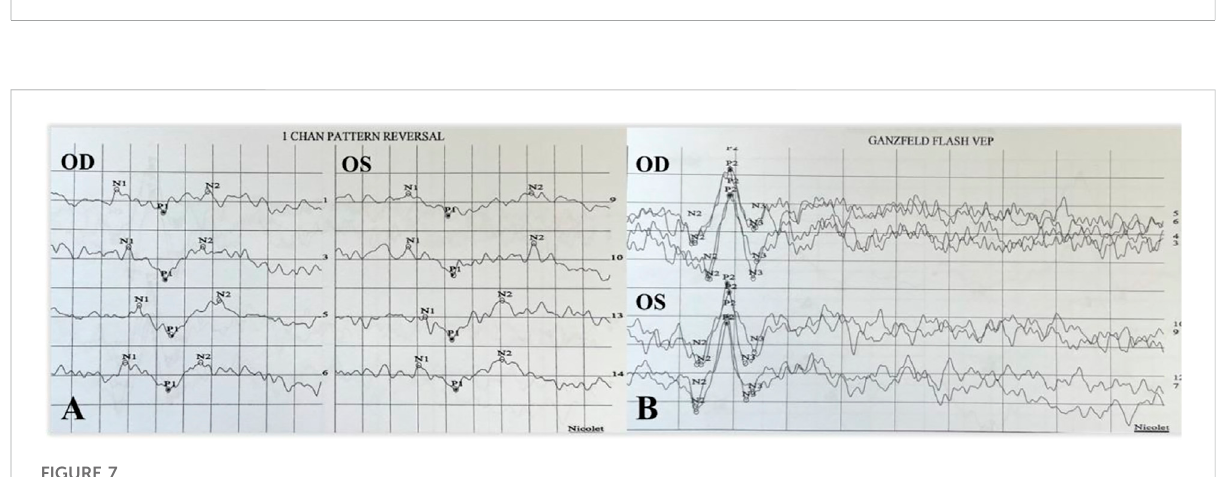
FIGURE 6 Examinationresultsoftheproband ’ smother. (A,B) Arcspotofmyopiaintemporalopticdiscs. (C,D) OCTshowedthattheinnerandouterlayers of central fovea were normal in both eyes. Optic nerve head analysis was normal. The thickness of inferior RNFL was normal, superior RNFL, and averageRNFLwasborderlineintheright.ThethicknessofsuperiorRNFLwasnormal,inferiorRNFL,andaverageRNFLwasborderlineontheleft.The thickness of superior GCC and average GCC was within normal range, and inferior GCC decreased. The focal loss volume (FLV) was within the normal range, and global loss volume was outside the normal range in both eyes.